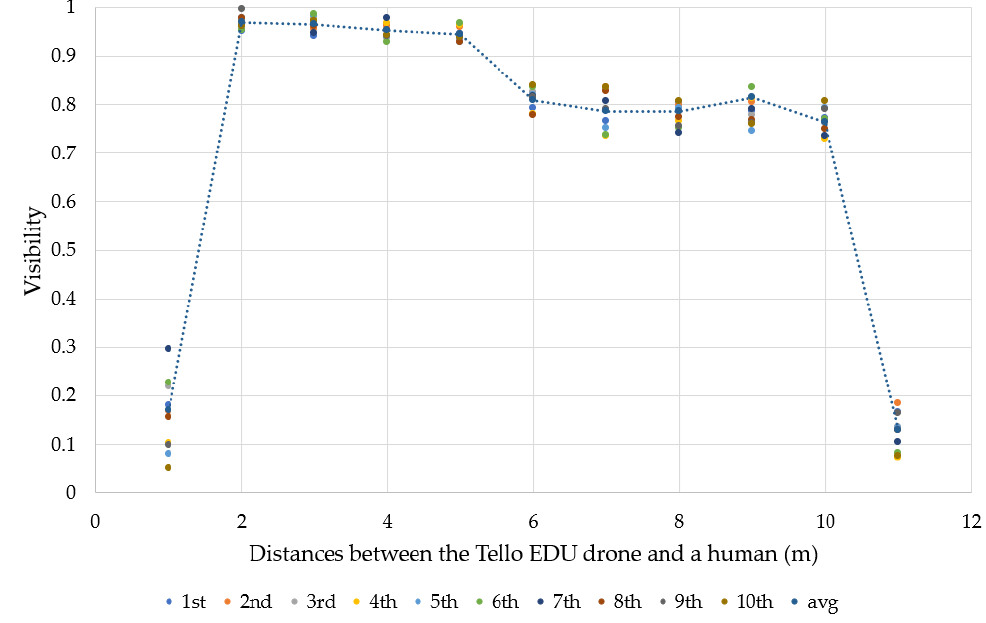
Figure 15. The relationship between visibility and distance